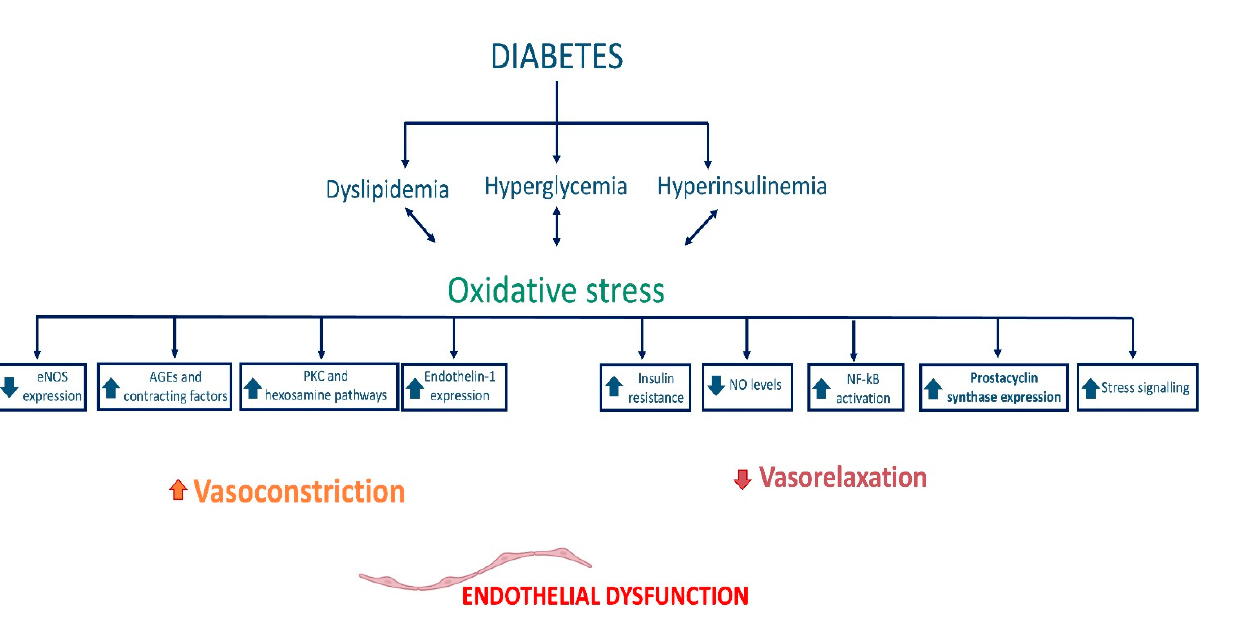
Figure 1. Pathophysiological elements of vascular damage in T2D, with a focus on the dysregulation of the balance between factors regulating vasoconstriction and vasodilation. Endothelial nitric oxide synthase (eNOS), advanced glycation end products (AGEs), protein kinase C (PKC), nitric oxide (NO), and nuclear factor kappa B (NF- κ B).